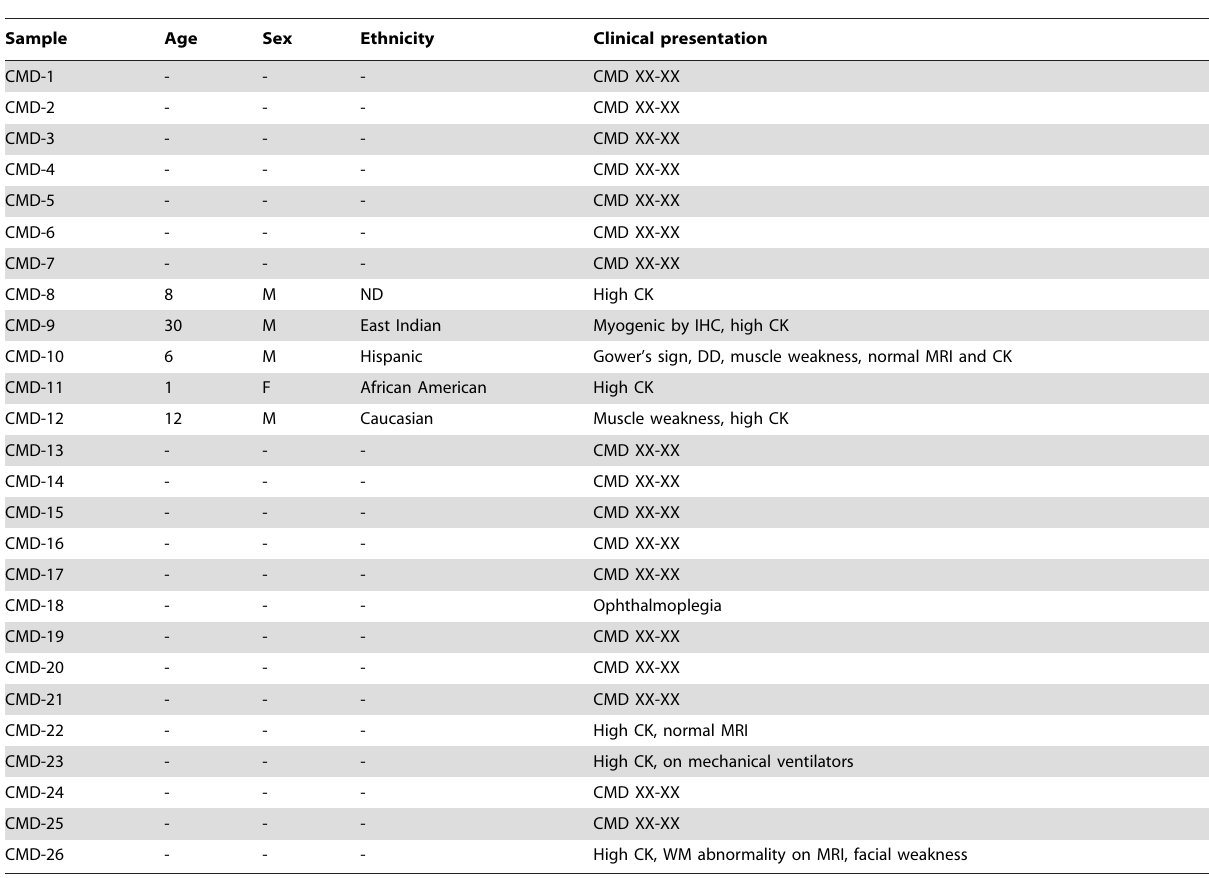
Table 1. Summary of the clinical features of CMD